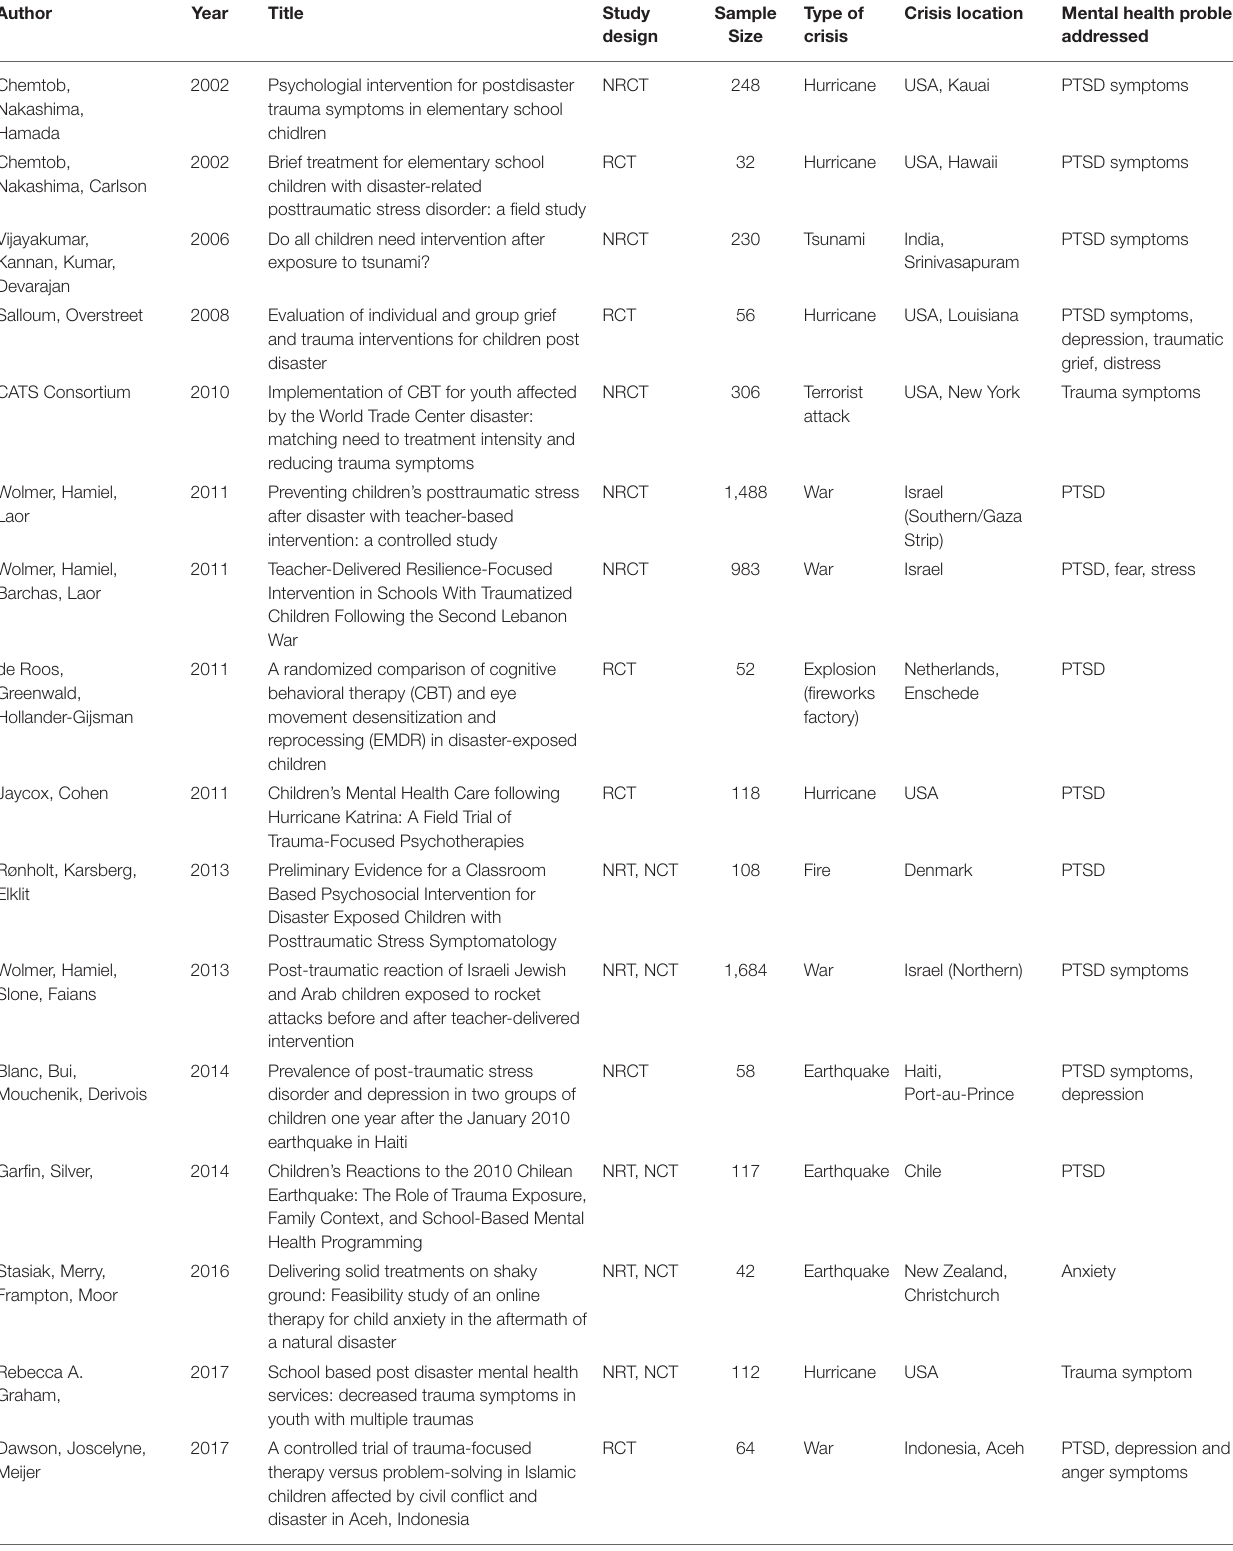
TABLE 1 | Characteristics of the included